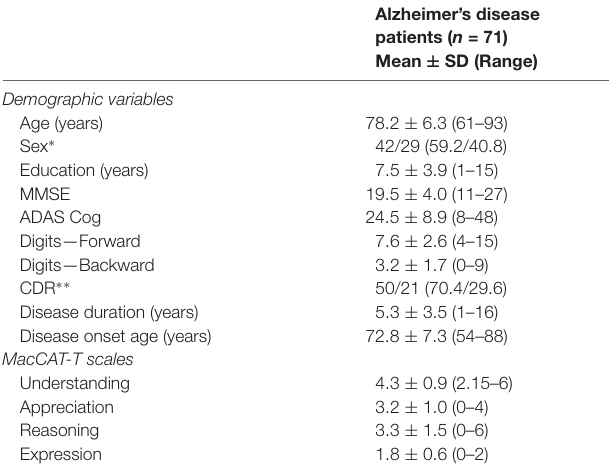
TABLE 1 | Participant characteristics and scores on the neuropsychiatric inventory (NPI) and MacArthur Competence Tool for Treatment (MacCAT-T).